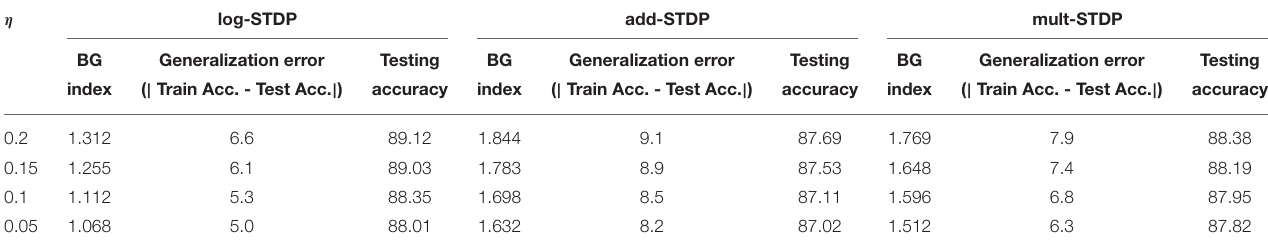
TABLE 4 | Table showing comparison of the STDP models on the fashion-MNIST dataset.